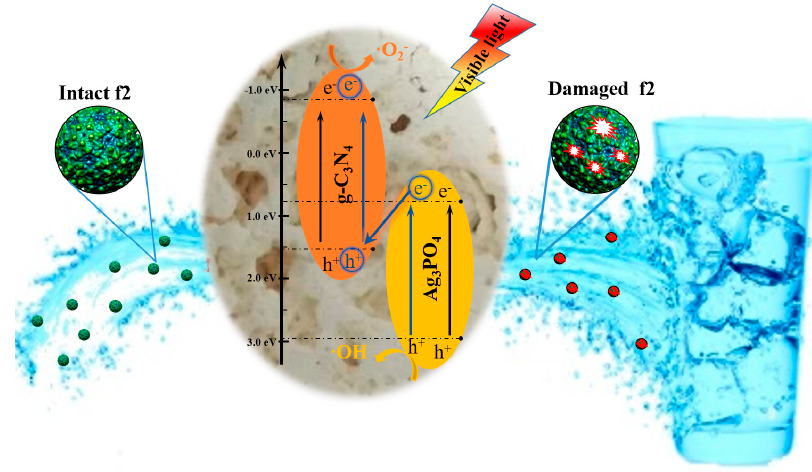
Figure 11. The possible mechanism of photocatalytic inactivation of bacteriophage f2 by the AgCN photocatalysts under visible light irradiation.